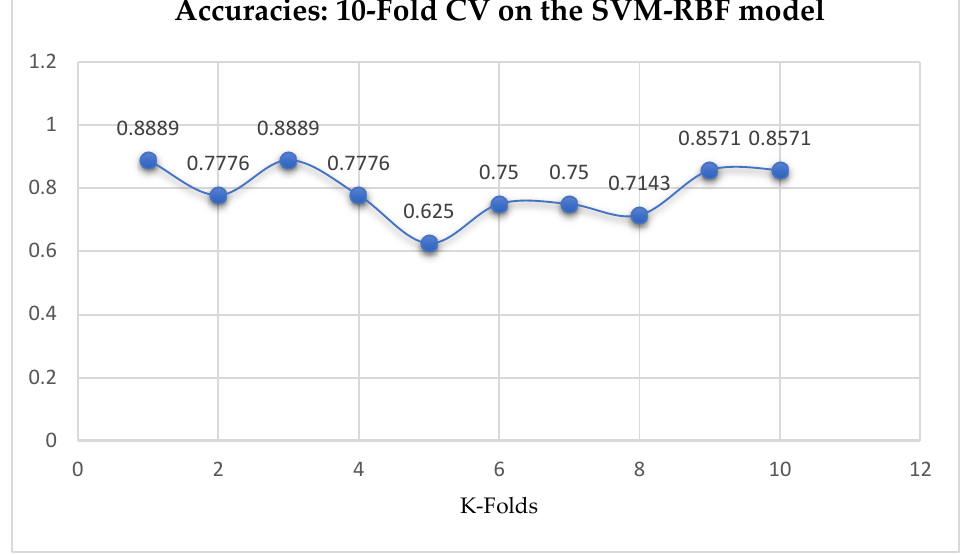
Figure 27. The accuracies achieved by the Folds after performing 10-Fold Cross-Validation on the SVM-RBF model.